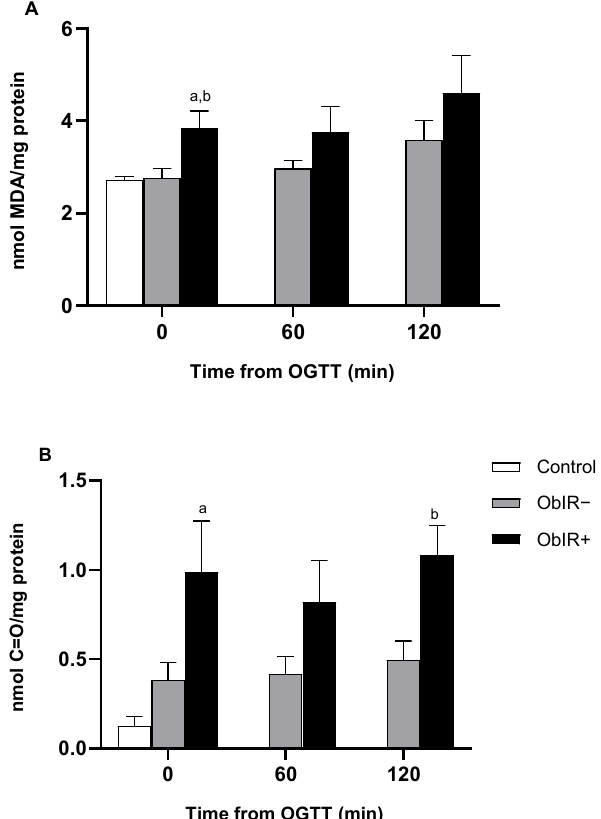
Figure 1. Levels of oxidative damage in red blood cells (RBCs) of healthy and obese children. Malondialdehyde (MDA) ( A ) and carbonyl group levels ( B ) were measured in RBCs at baseline and along oral glucose tolerance test (OGTT). White bars represent the control group, grey bars represent ObIR − group, and black bars represent obese children with insulin resistance (ObIR+) group. Values are means ± SEM. p < 0.05 was considered for statistical significance. (a) shows significant differences relative to control at baseline and (b) shows significant differences relative to ObIR − .